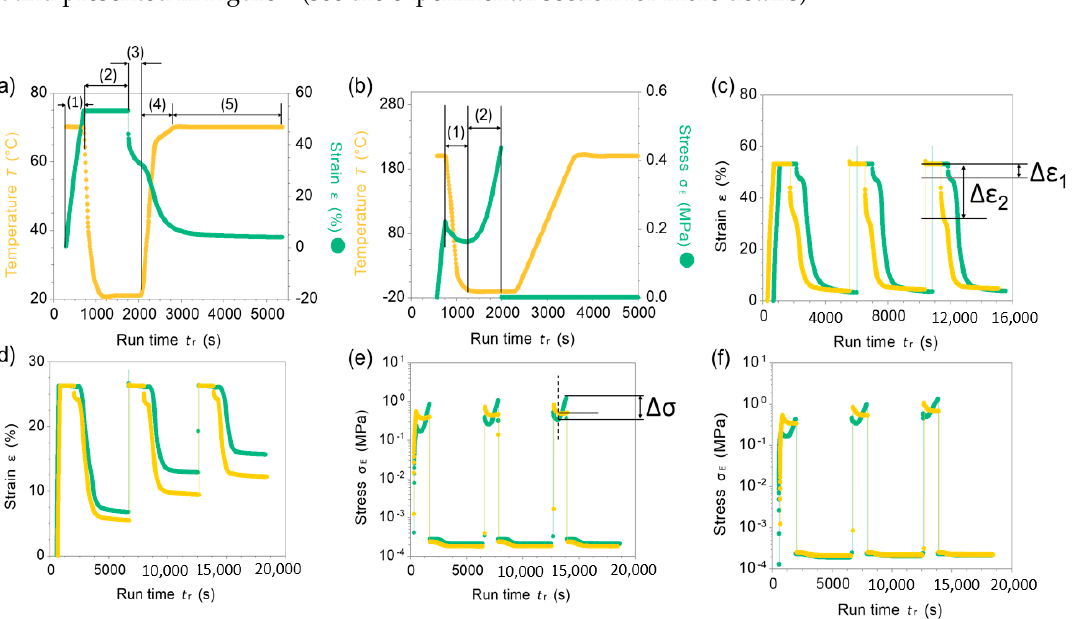
Figure 6. ( a ) Shape programmability (1 and 2) of NBR-S lignin at 70 °C and shape recovery of the sample at 70 °C after fixing. ( b ) Shape programmability (1 and 2) of NBR-I lignin at 70 °C and shape recovery of the sample at 70 ◦ C after fixing. ( c ) Shape programmability (1 and 2) of NBR-S lignin at recovery of the sample at 70 °C after fixing. ( c ) Shape programmability (1 and 2) of NBR-S lignin at 150 ◦ C and shape recovery of the sample at 150 ◦ C after fixing. ( d ) Shape programmability (1 and 2) of 150 °C and shape recovery of the sample at 150 °C after fixing. ( d ) Shape programmability (1 and 2) NBR-I lignin at 150 ◦ C and shape recovery of the sample at 150 ◦ C after fixing. of NBR-I lignin at 150 °C and shape recovery of the sample at 150 °C after fixing.